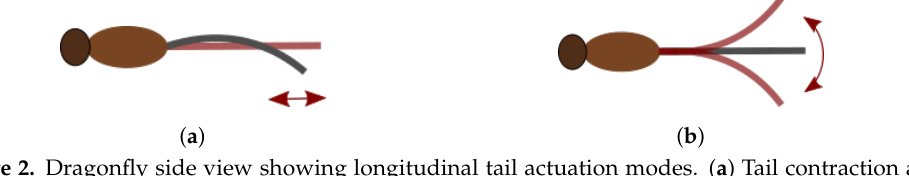
Figure 2. Dragonfly side view showing longitudinal tail actuation modes. ( a ) Tail contraction and extension. ( b ) Tail up down wag